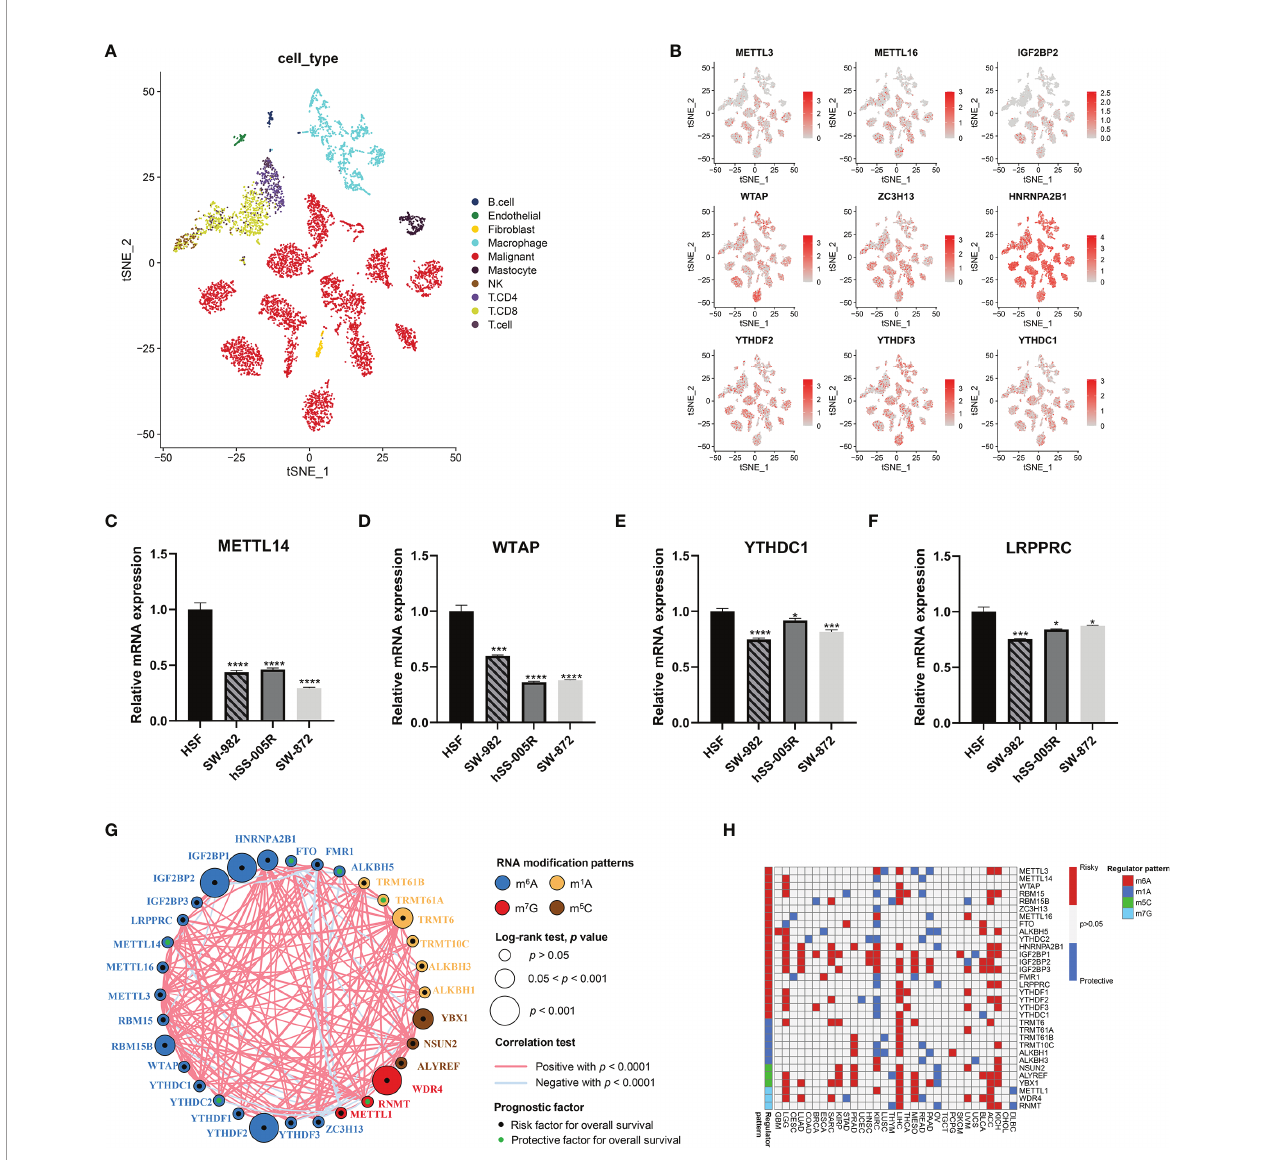
FIGURE 3 | Validation and interaction of RNA modi fi cation regulator expression in STS. (A) The t-SNE plot demonstrating speci fi c cell clusters. Each color corresponds to one cell type. (B) The t-SNE plots illustrating the expression level of speci fi c genes. (C – F) Validation of expression of RNA modi fi cation regulators in cell lines. (G) The interaction of RNA modi fi cation regulator expression in STS. The colors represent the types of RNA modi fi cation. The size of the circles indicated the prognostic effect assessed by p -value. The dots within the circles represent the prognostic roles including protective factor (green) and risk factor (black). (H) The prognostic roles of 32 RNA modi fi cation regulators across cancers in TCGA. Red indicates the higher regulator expression related to poor survival, while blue suggests the association with good survival. Only statistically signi fi cant prognostic factors were present. *, 0.01 ≤ p < 0.05; **, 0.001 ≤ p < 0.01; ***, 0.0001 ≤ p < 0.001; ****, p <